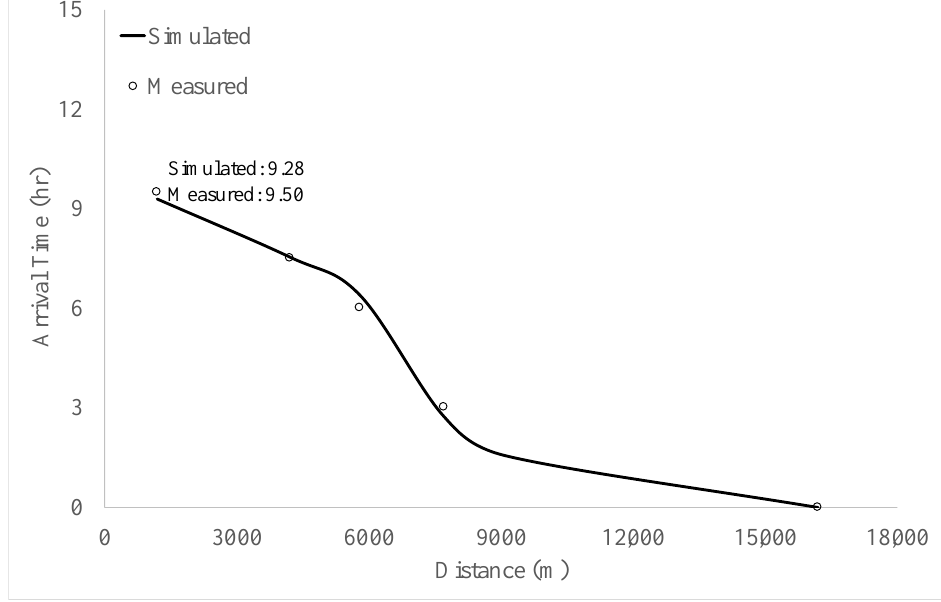
Figure 7. Arrival time at sections during Typhoon Soudelor (Lofu, at the location of 16,200 m is defined to the inflow boundary. In addition, S24 is located at 9100 m, S20 is located at 7700 m, S15 is located at 5800 m, S12 is located at 4200 m, and S07 is located at 1200 m).